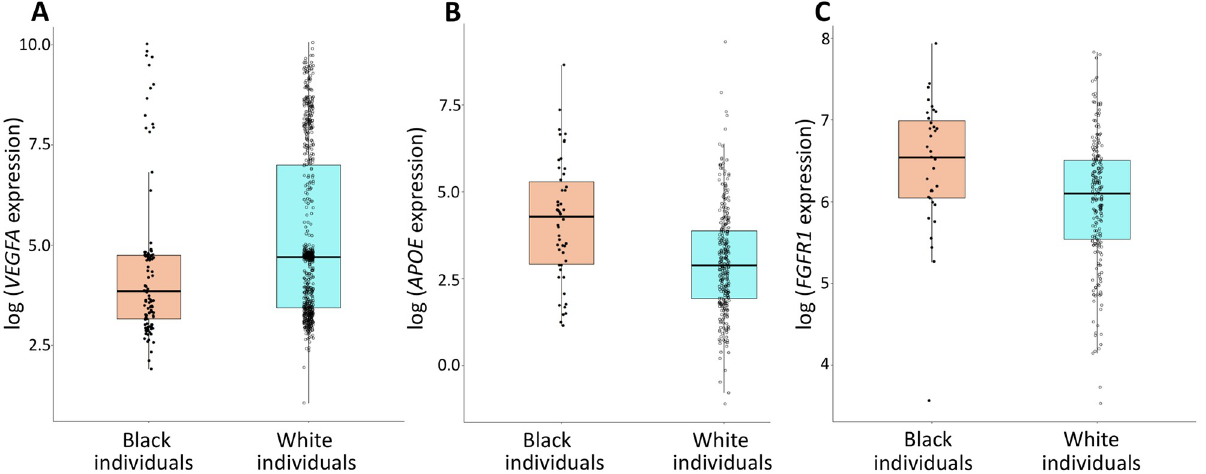
Fig 6. Differential expression of VEGFA , APOE , and FGFR1 between Black and White individuals. (A) Down-regulation of VEGFA expression in whole blood from Black, as compared to White individuals. (B) Up-regulation of arterial APOE expression in Black, as compared to White individuals. (C) Up-regulation of FGFR1 expression in non-sun-exposed skin from Black, as compared to White individuals.